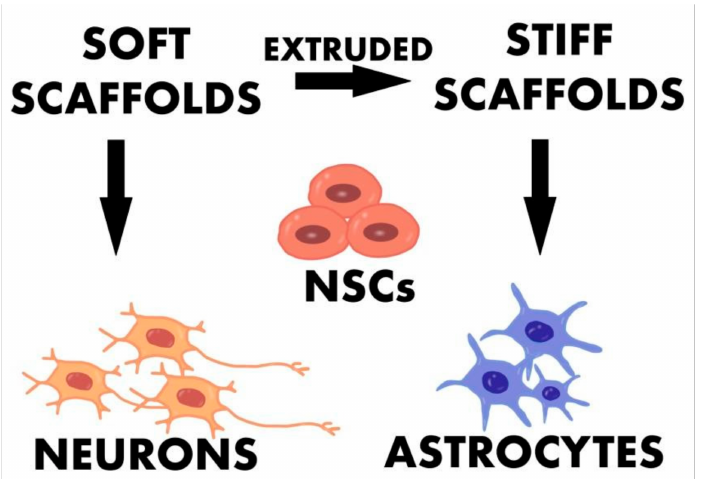
Figure 5. Schematic visualization of relationship between the stiffness of scaffolds and cell